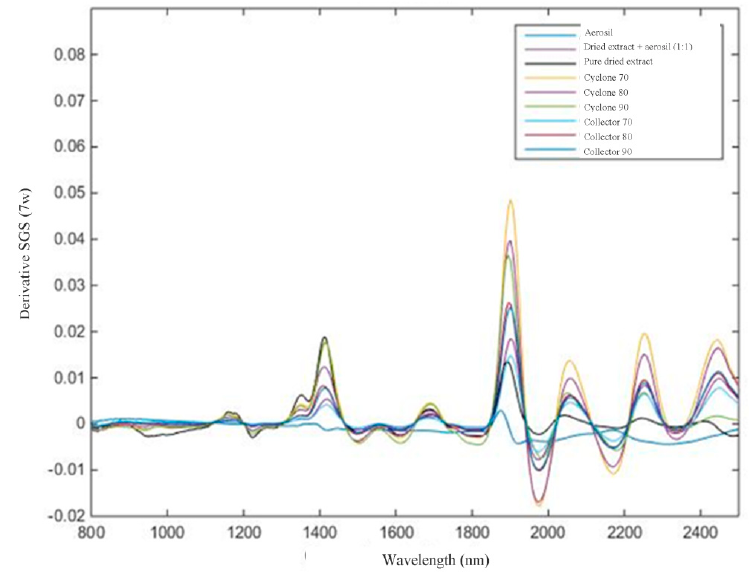
Figure 5. spectral data obtained from 800 to 2500 nm after Savitzky–GolaySmoothing (SGS) 7w.